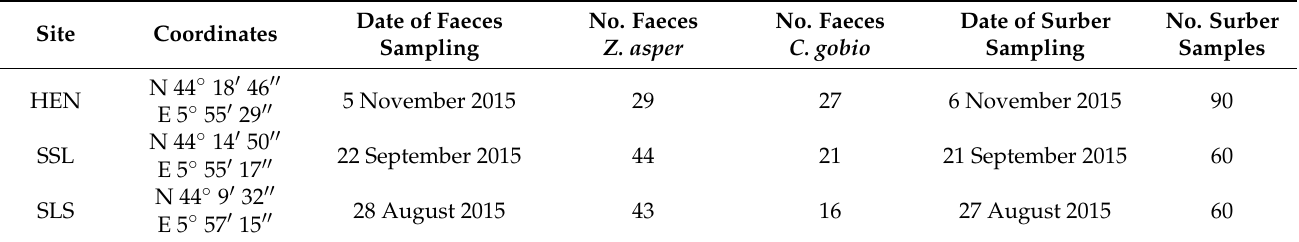
Table 1. Details of faeces and macroinvertebrate